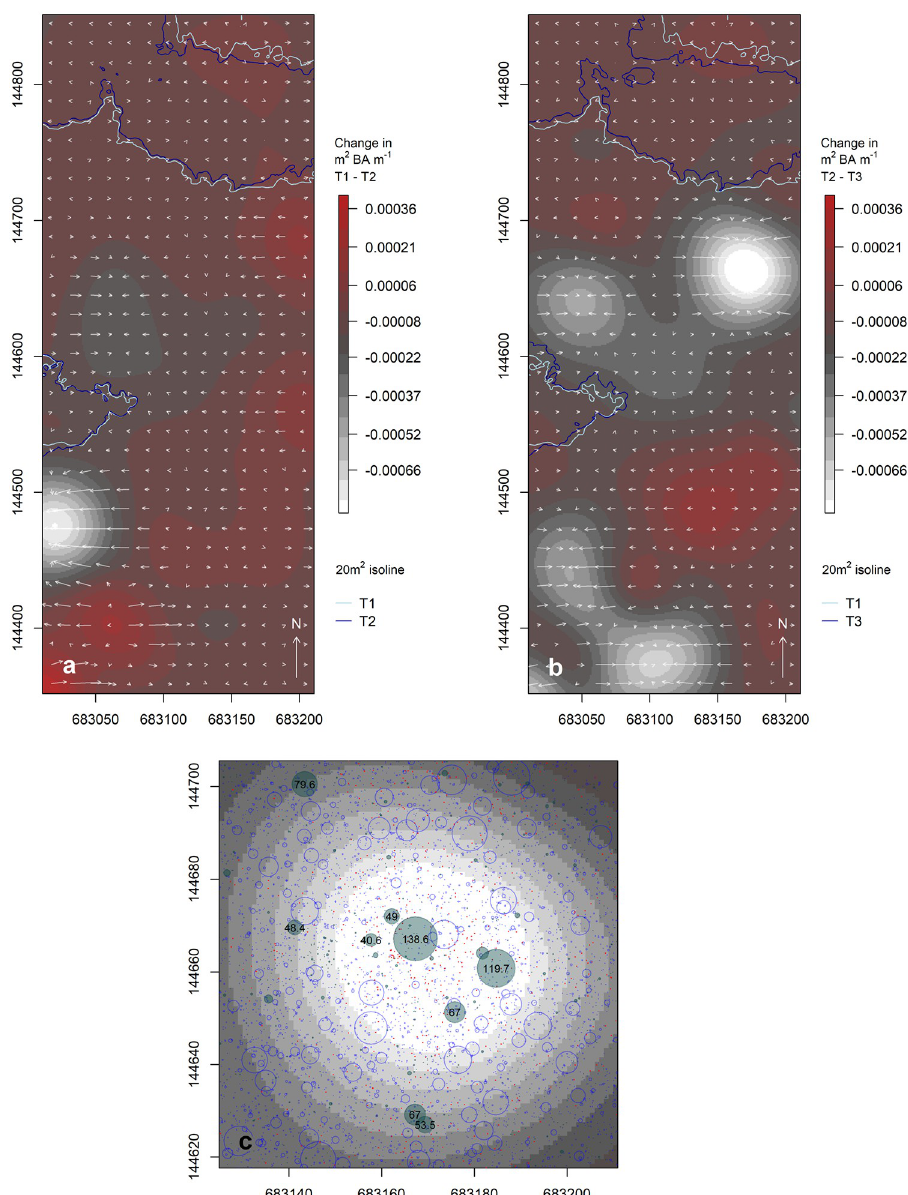
Fig 5. Gap dynamics on the lenda2 field site. Gap dynamics between (a) the first (1994–1995; T1) and second (2001– 2002; T2) censuses, and (b) the second (2001–2002; T2) and third (2007; T3) censuses. See Fig 4 caption for vector field description. The most prominent gap visible on the eastern margin of (b) is detailed in (c), where blue circles represents stems present at the time of the first and second censuses, red dots represent stems recruited between the second and third censuses, and shaded circles represent stems lost between the second and third censuses. Stems � 40 cm DBH have been labeled, and stem symbols have been scaled uniformly to ensure visual clarity. All coordinates are in UTM 35N